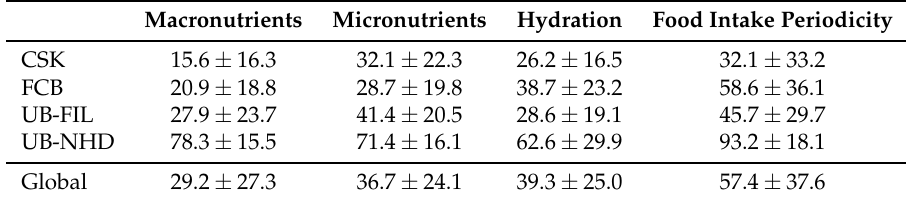
Figure 1. ( Left ) Item difficulty indices for each questionnaire item. Ninety percent of the items are within the range (0.2, 0.8). Items outside of that range are highlighted in red. ( Right ) Item discrimination indices for the same items. All questions positively discriminate high-scored respondents from low-scored ones. Table 4. Averages and standard deviations ( ¯ x ± s ) for sectional normalized scores, for each group and